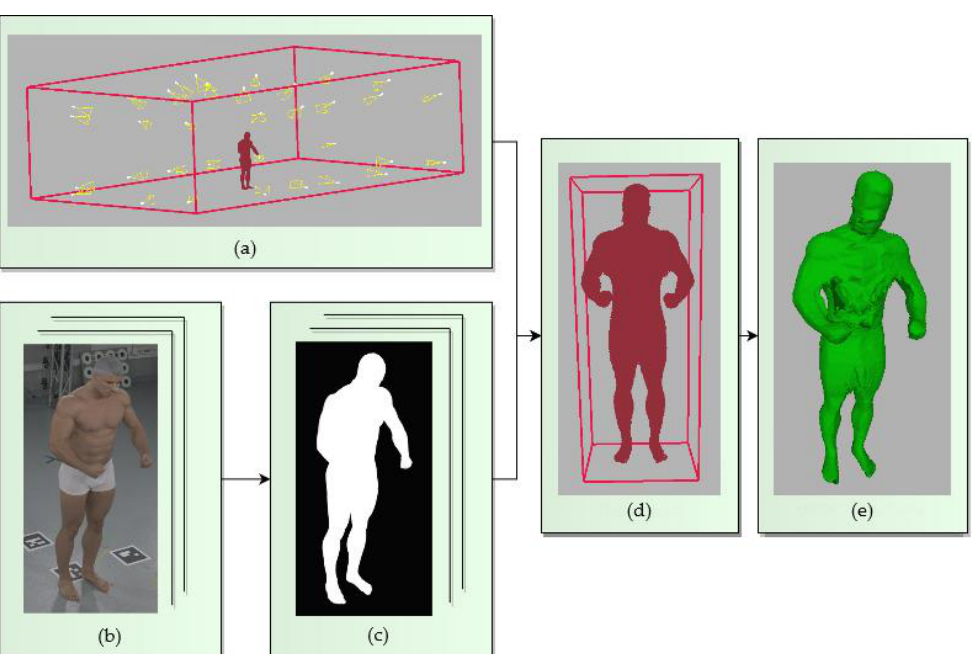
Figure 2. Steps involved in the conventional SfS reconstruction method of an object: ( a ) the volume of the whole reconstruction system, estimated with the cameras’ positions; ( b ) input RGB images; ( c ) silhouette images of the subject; ( d ) approximate subject volume from the transition step (see Figure 3 for details); ( e ) final visual hull estimation with the target voxel size.